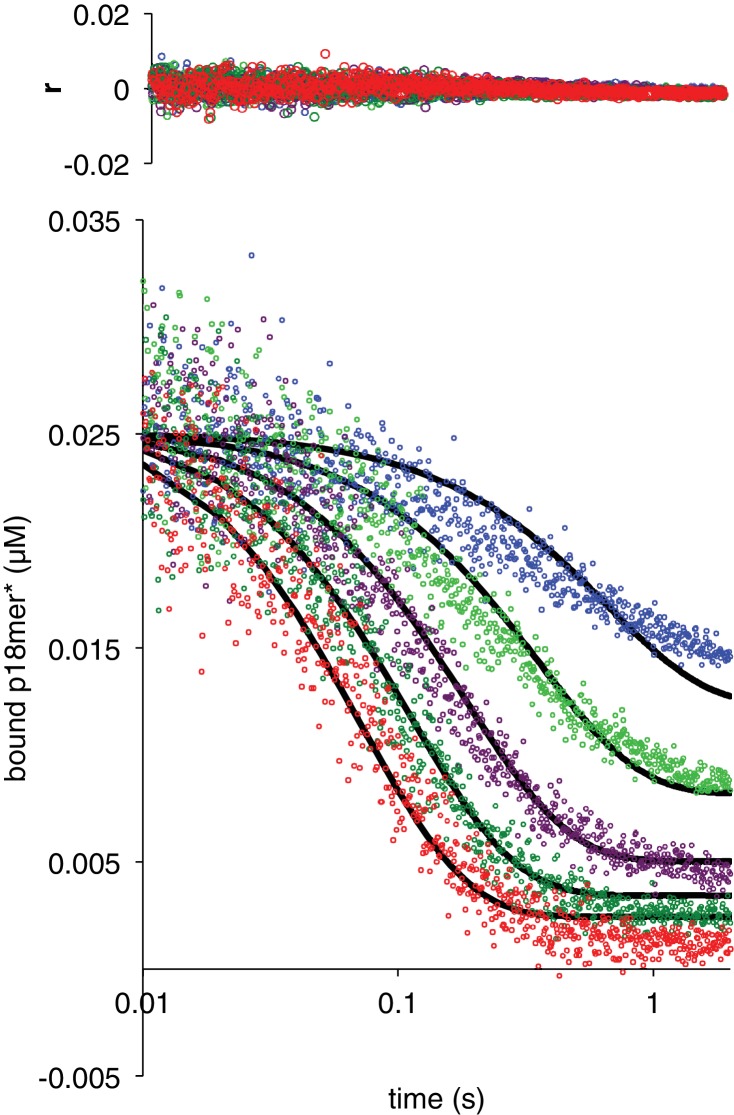
Dissociation of ΔZn3 from p18mer*.Global fits of five representative concentrations of competitor DNA are shown: 0.15 µM (blue), 0.4 µM (light green), 1 µM (violet), 2 µM (dark green), and 4 µM (red) to the kinetic mechanism in Scheme 3. Residuals for the five concentrations are shown overlaid in the corresponding colors above each plot.10.7554/eLife.37818.037Figure 4—figure supplement 5—source data 1.Dissociation of ΔZn3 from p18mer*.